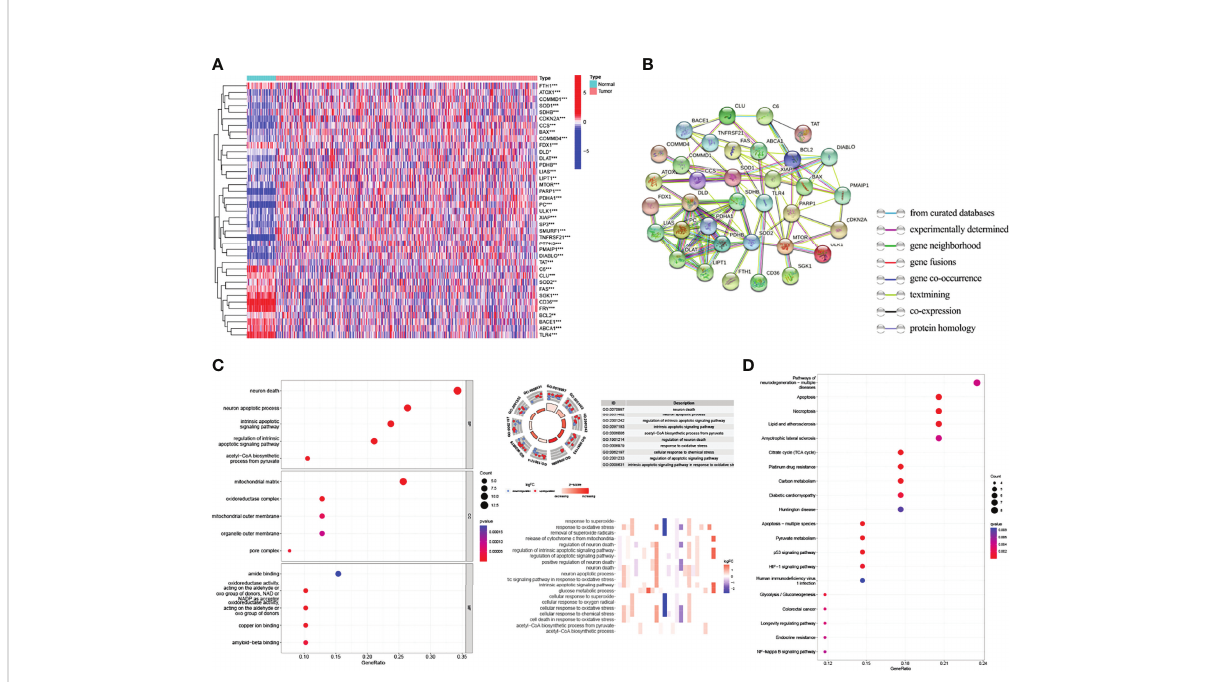
FIGURE 2 Identi fi cation of the expression and functional enrichment of cuproptosis-related genes in lung adenocarcinoma (LUAD). (A) Heat map re fl ecting the distribution of the 39 cuproptosis-related genes in LUAD and normal tissues. Red: upregulation; green: downregulation. (B) PPI network showing the interaction among 39 cuproptosis-related genes. (C) GO enrichment of cuproptosis-related genes. (D) Enriched KEGG pathways of cuproptosis-related genes. PPI, protein – protein interaction network; GO, Gene Ontology; KEGG, Kyoto Encyclopedia of Genes and Genomes. *p < 0.05; **p < 0.01; ***p <